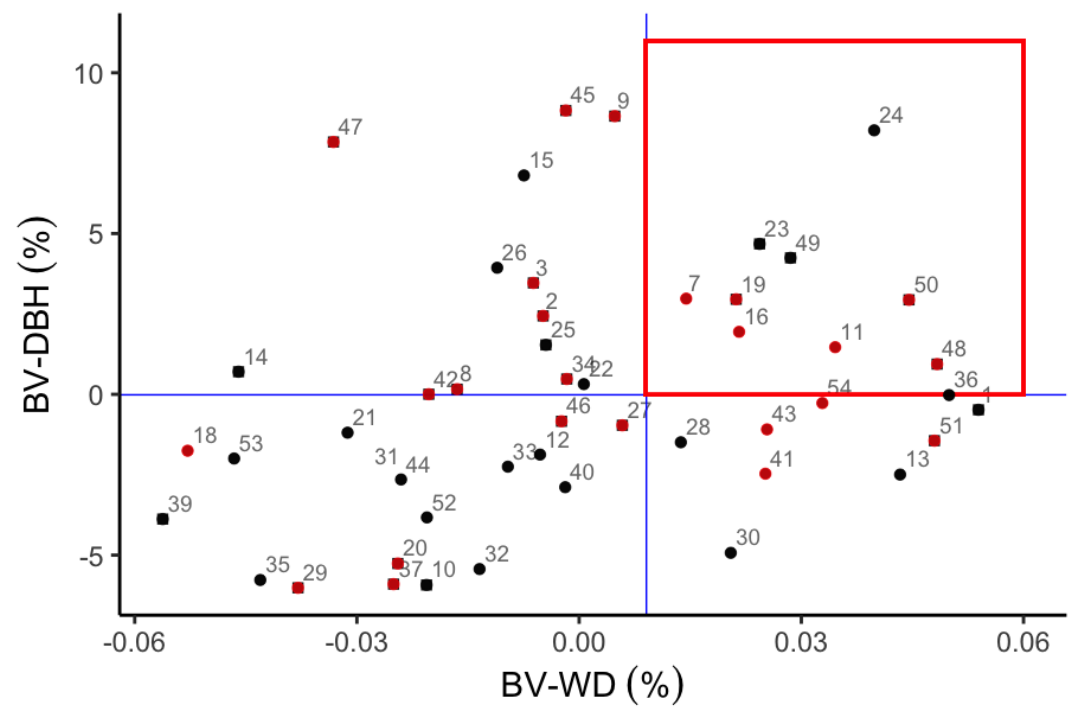
Figure 3. Relationship between DBH, WD, HC, and lignin breeding values of P. elliottii family. Red and black: Breeding value of lignin above and below mean; dot and square: Breeding value of holocellulose above and below mean; BV-Den: Breeding value of wood density; BV-DBH: Breeding value of diameter at breast height (DBH).